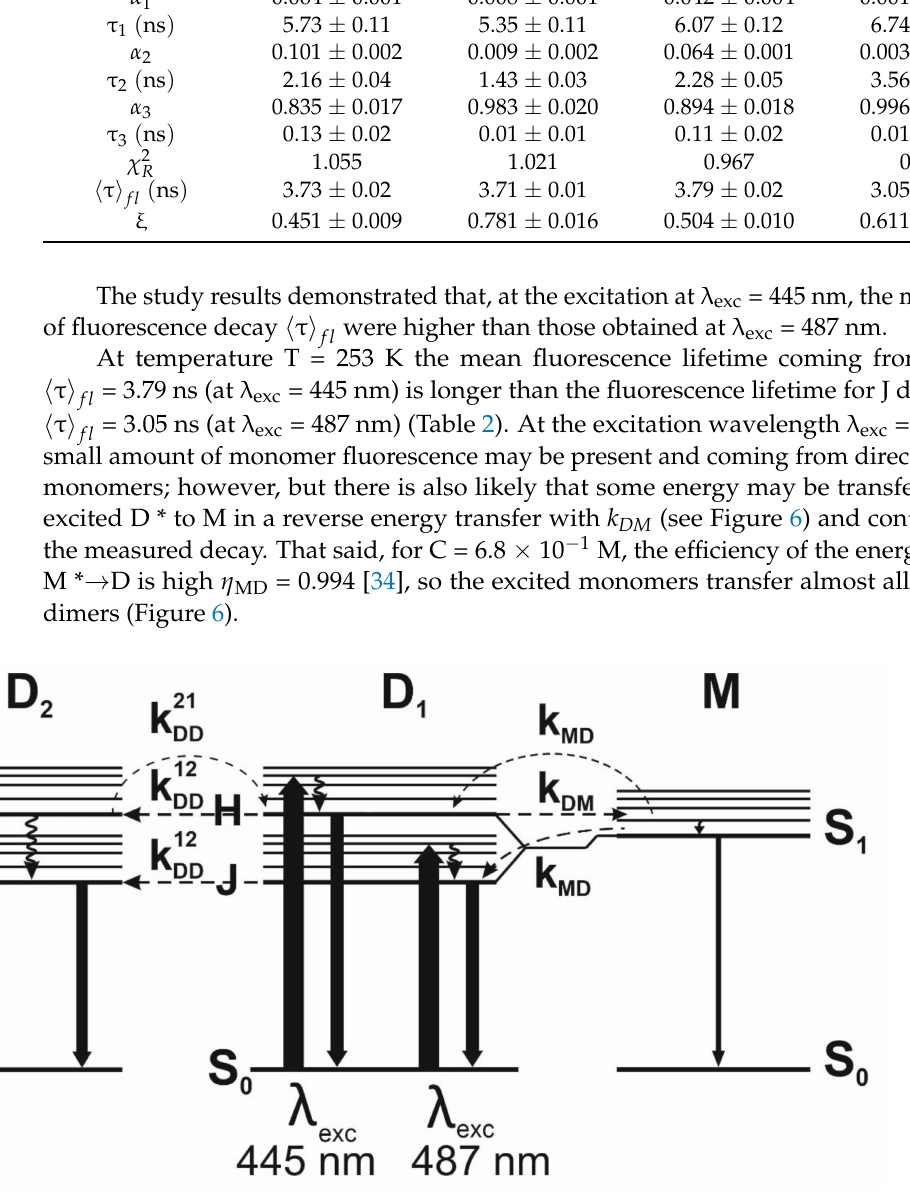
Figure 6. Diagrams of energetic levels for FMN monomers M and dimers D, with possible ways of energy transfer at excitation to H and J dimer